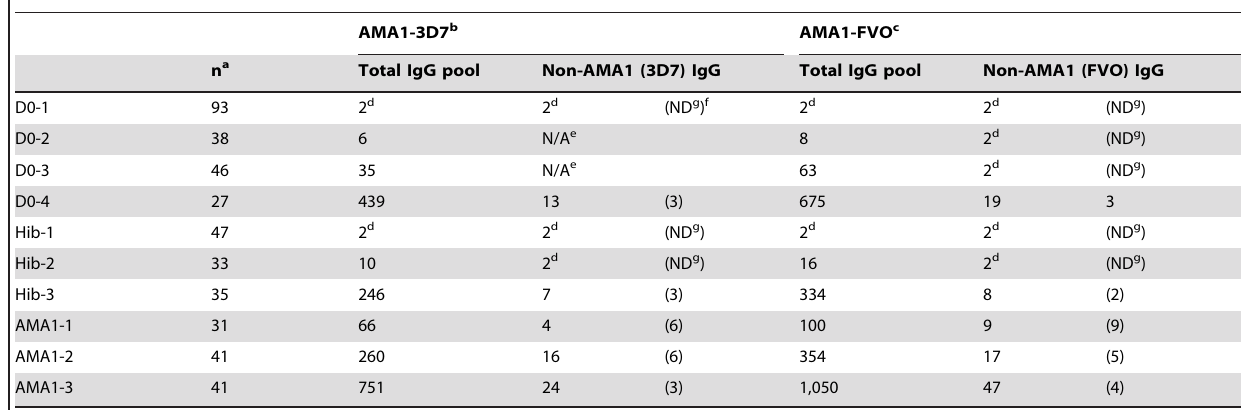
Table 1. Anti-AMA1 antibody level [mg/ml] in test IgGs (40